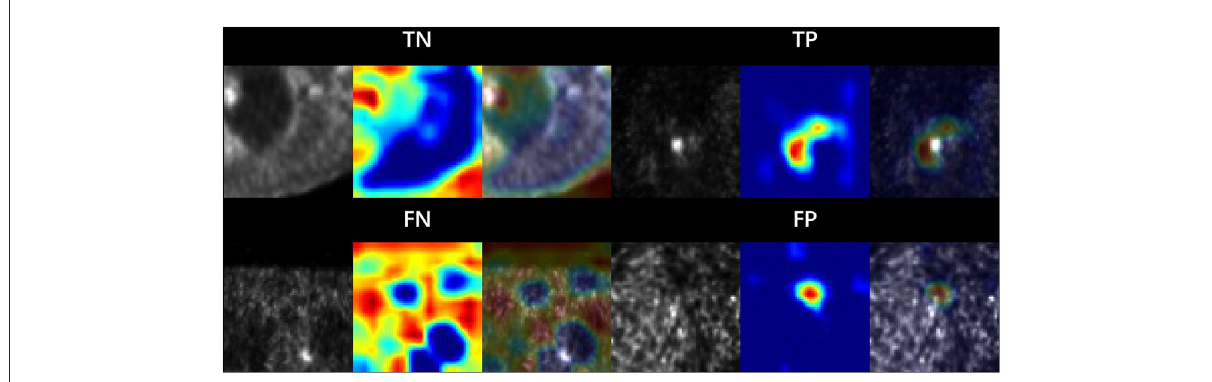
FIGURE4 Sample patches with different categories. The area is highlighted by the model CAM. Where TP, TN, FP and FN are corresponds to true positive, true negative, false positive and false negative, respectively.